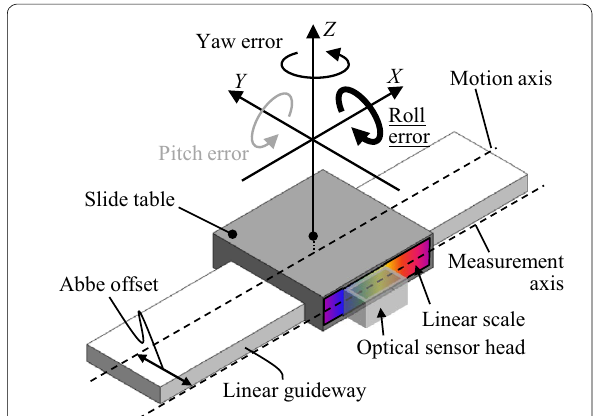
Figure 1 A schematic of tilt error motions of a linear